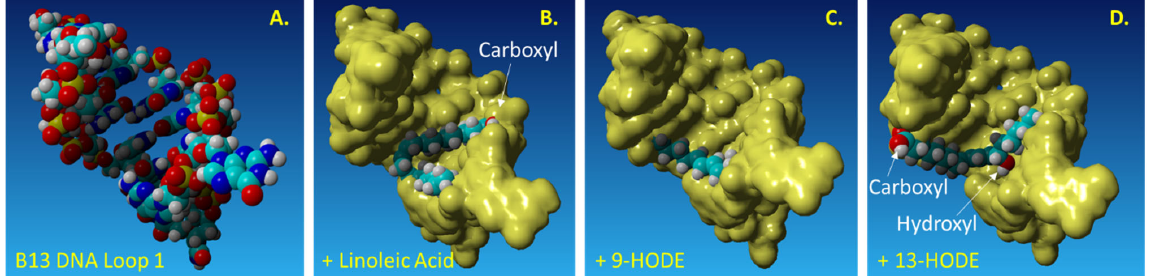
Figure 3. ( A – D ) A truncated aptamer loop designated B13 was developed against 13 ‐ HODE,